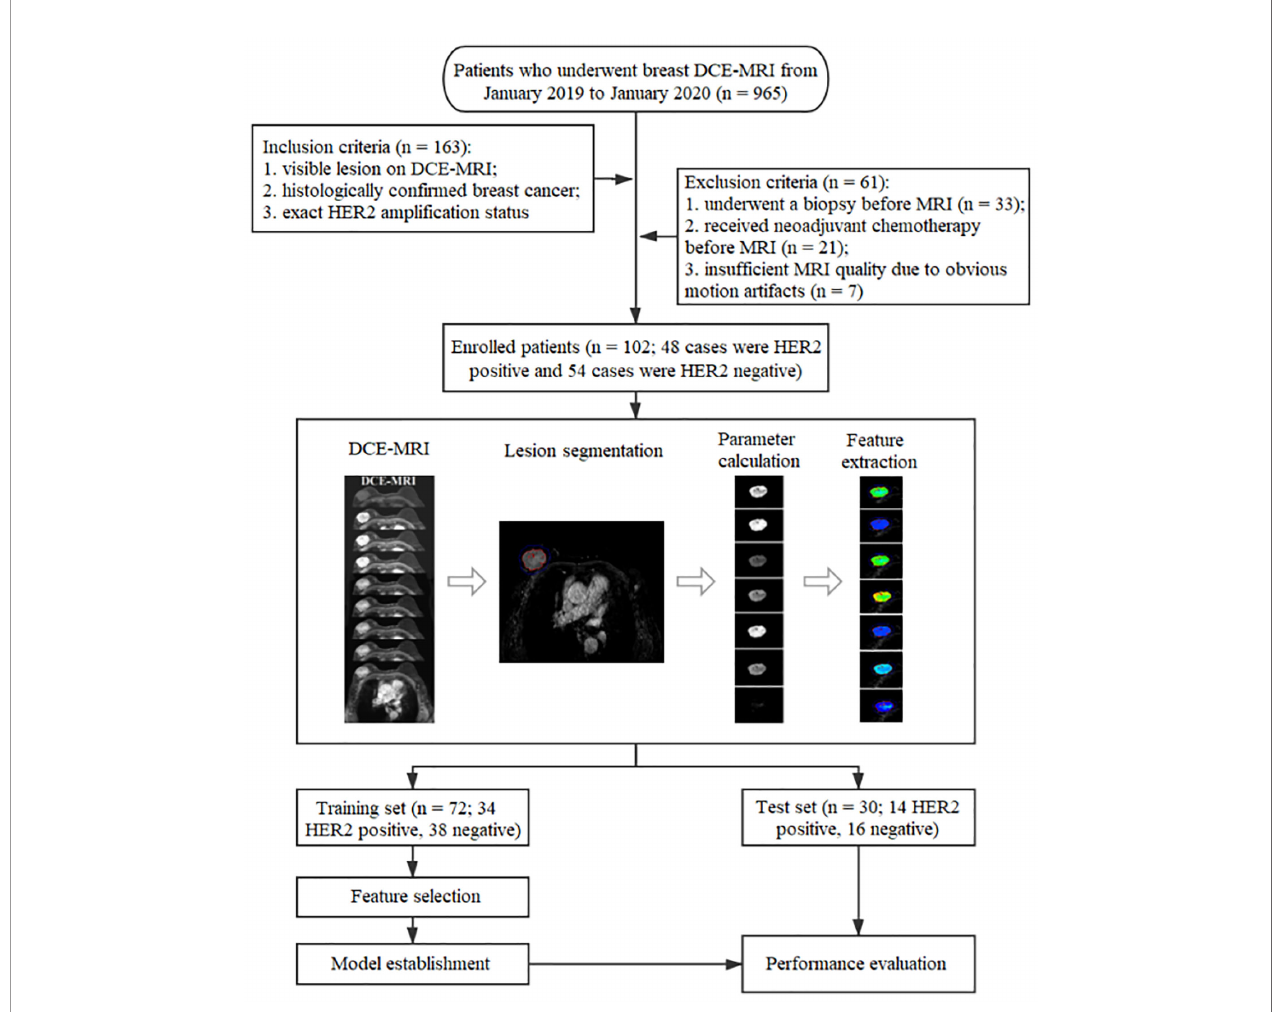
FIGURE 1 | The work fl ow of this